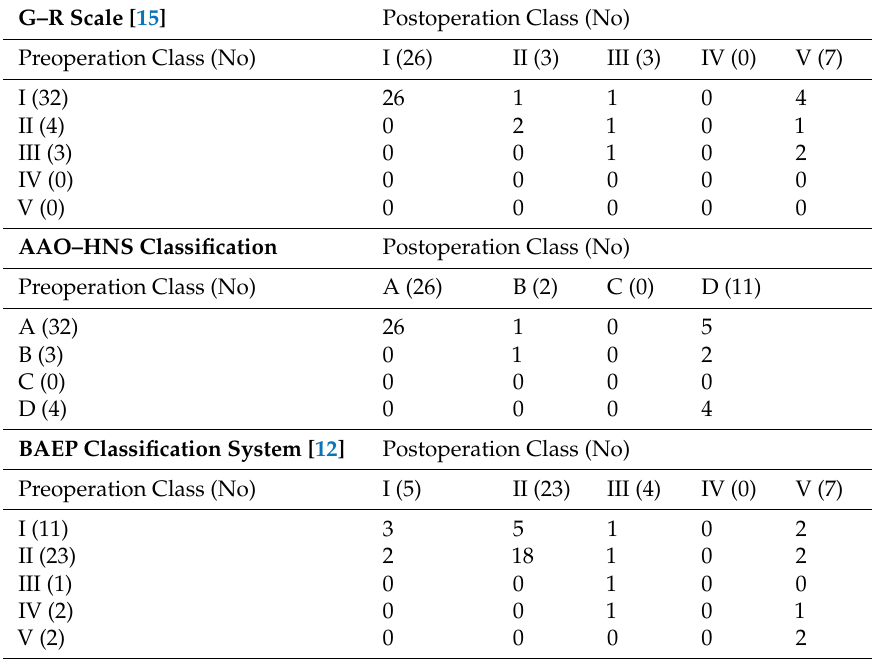
Table 2. Preoperative and postoperative hearing classifications in 39 operated